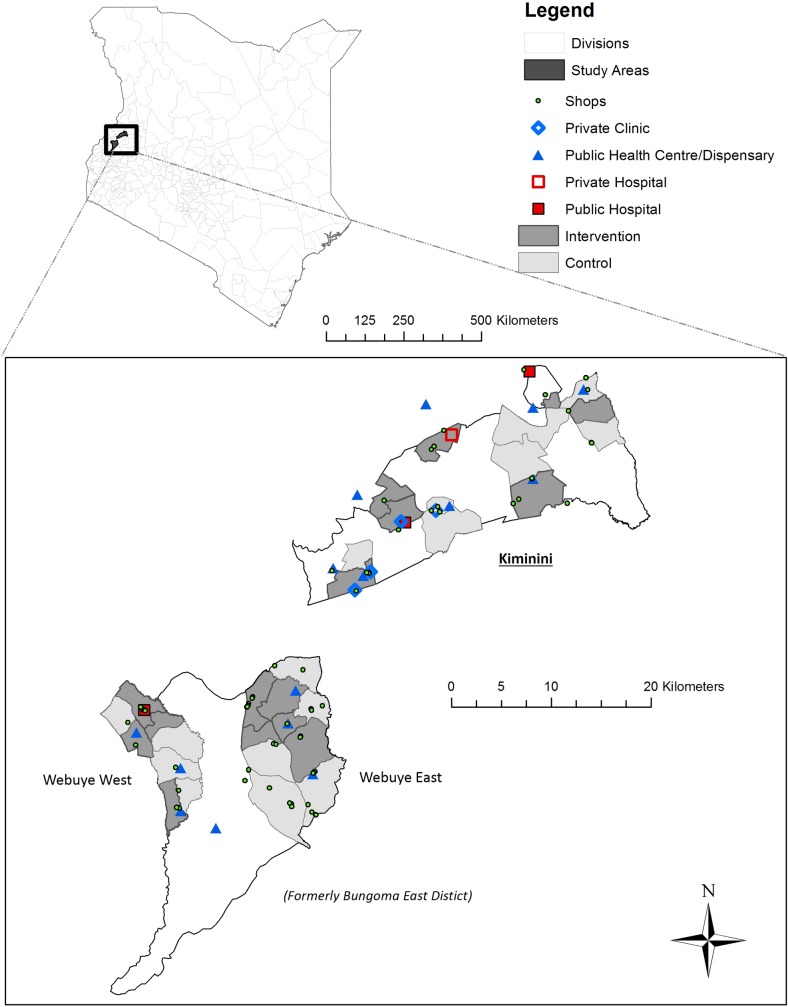
Map of the study area showing intervention and comparison clusters (i.e., CUs).Bungoma East was divided into multiple subcounties after the study began. Webuye West and Webuye East were previously divisions within Bungoma East subcounty and are now separate subcounties. In Laktabai and colleagues [10], we refer to Bungoma East and Kiminini. Here, we have used the updated administrative structure. CU, community unit.